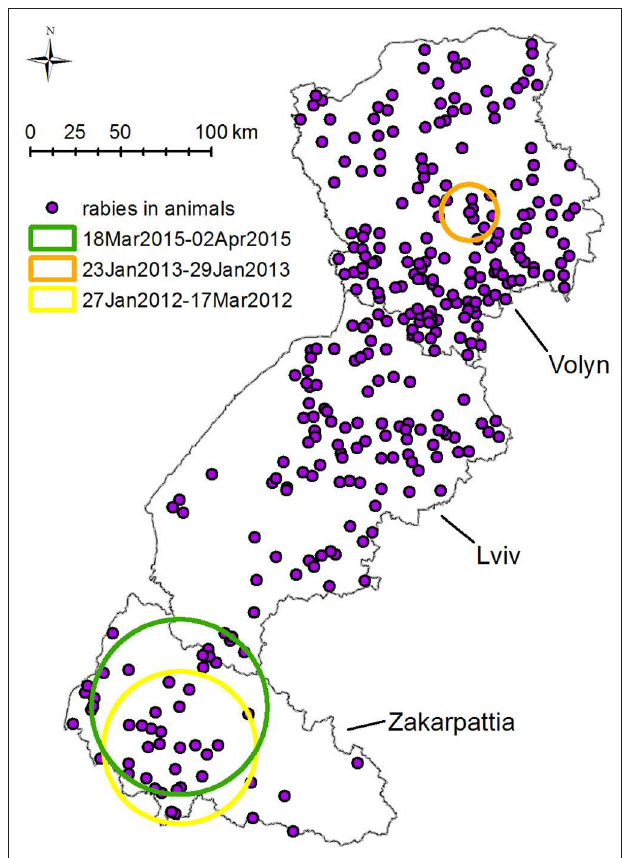
FIGURE 6 | Spatiotemporal clustering of rabies cases in all species in Volyn, Lviv, and Zakarpattia oblasts from 2012 to 2016 detected using space–time permutation model in SatScan. Three spatiotemporal clusters with p < 0.05 were detected: (1) yellow circle: 41.9km radius—present in 2012 from January 27 to March 17, displaying seven cases of rabies (two in foxes, three in dogs, and two in cats). (2) Orange circle: 15.4km radius—present in 2013 from January 23 to January 29, displaying five cases of rabies four in foxes and one in raccoon dog. (3) Green circle: 48.2km radius—present in 2015 from March 18 to April 2, displaying five cases of rabies (three in foxes and two in